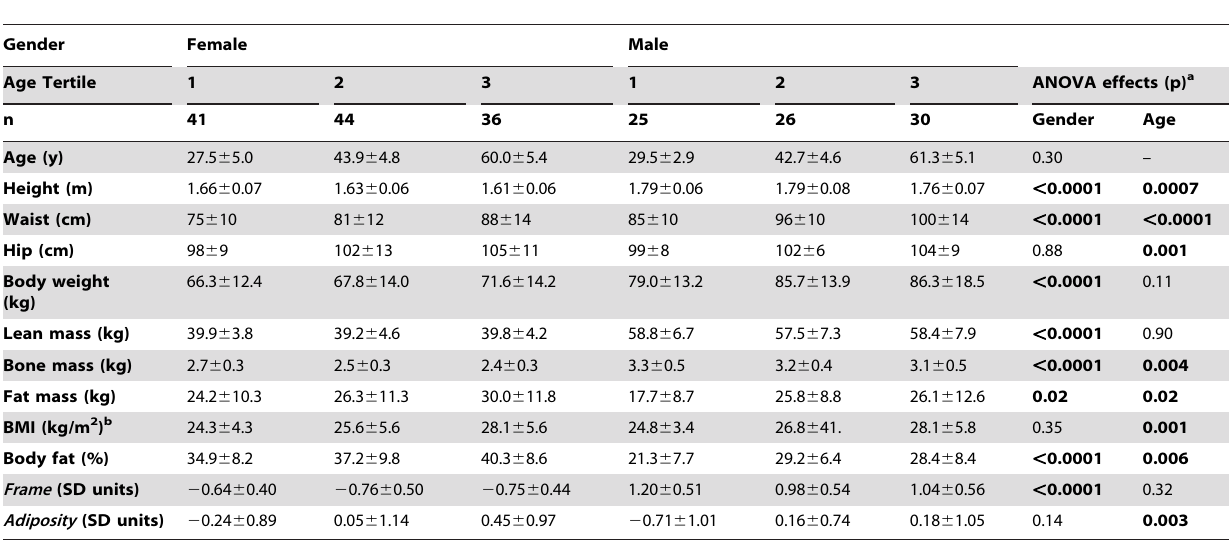
Table 2. Anthropometry, body composition, Frame and Adiposity factor scores by gender and age tertile. Mean 6 SD.